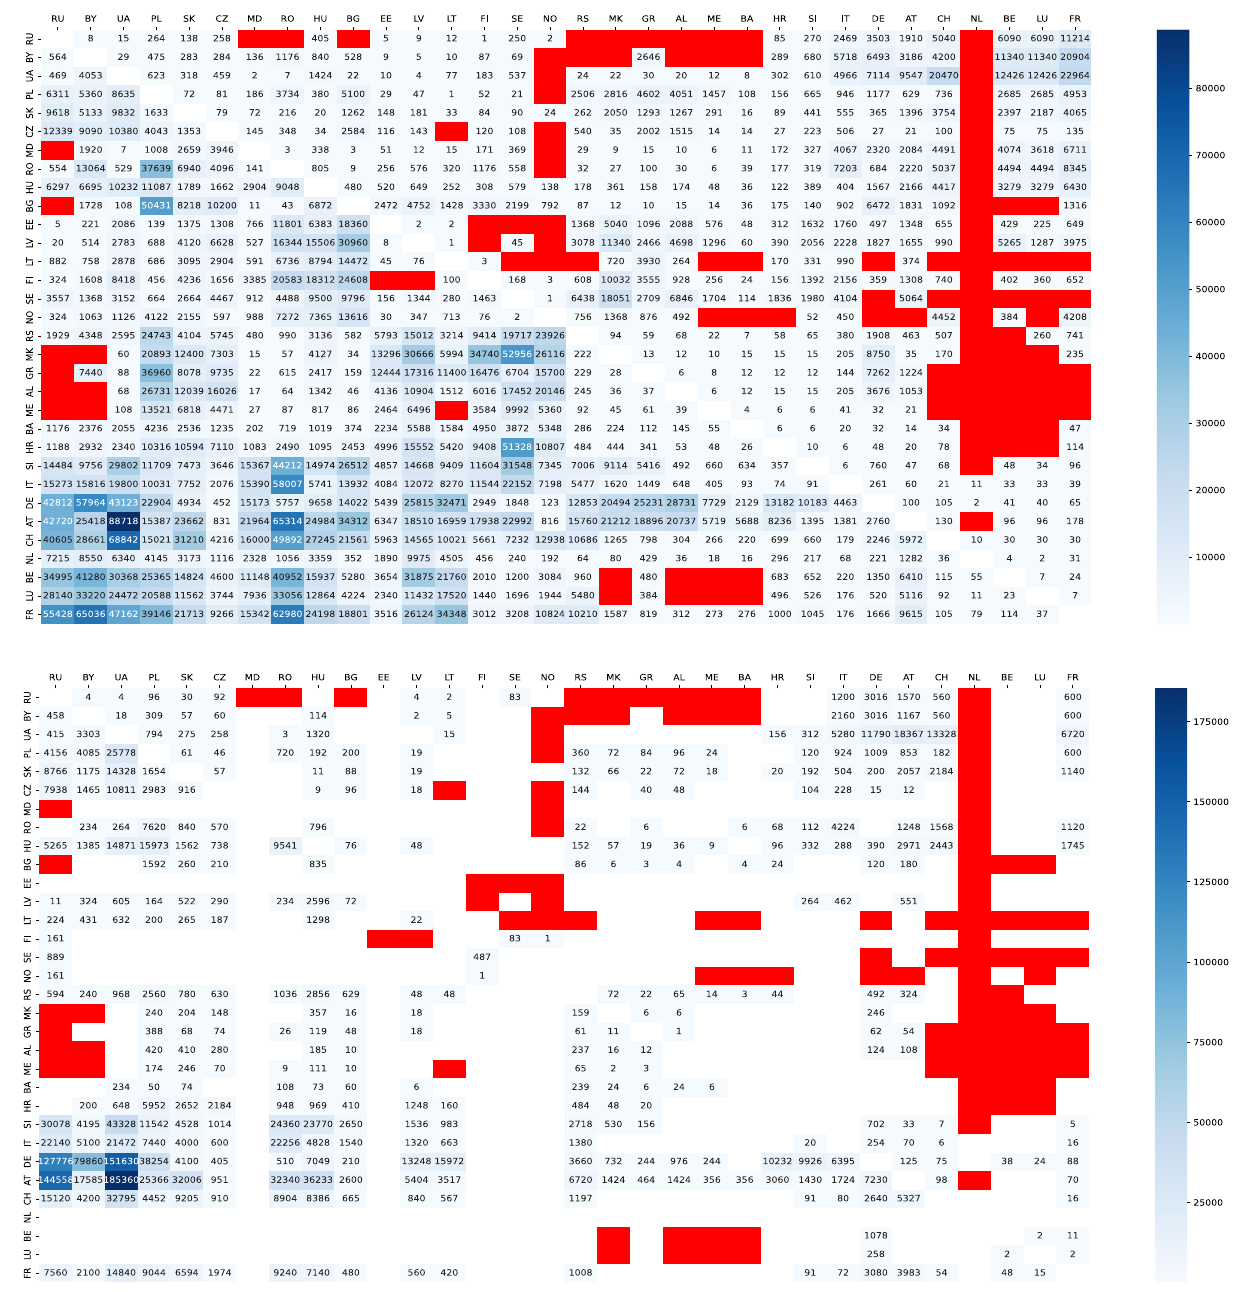
Figure 3. Heatmap for the combination number of (Top) k = 2 or (Bottom) 3 non-intersecting paths on a planar network defined by neighboring countries in Europe. The right color bar indicates the number of paths from zero (white) to the maximum (blue) by gradation. The case of no substitutive path is emphasized by red. The upper triangle represents the numbers for choosing the nearest neighbors as start s i and end t j points, while the lower triangle represents the numbers for choosing the next-nearest neighbors as start s i and end t j